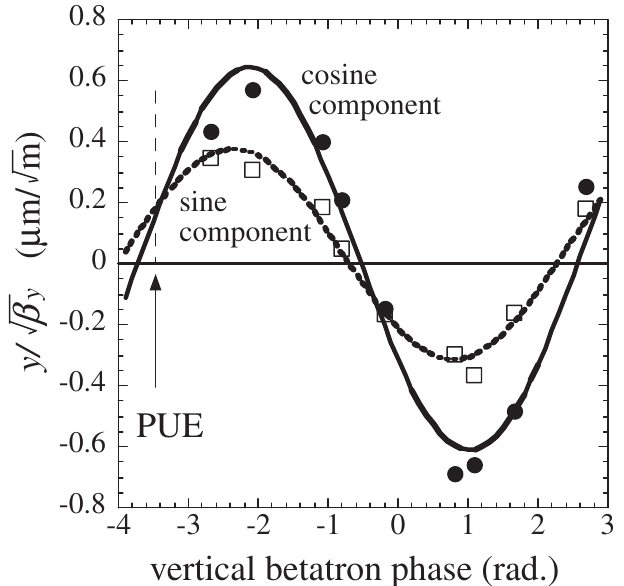
FIG. 6. The cosine and sine components of the vertical oscil- lation amplitude at 60 Hz, measured in the eastern arc. The PUE is located between the two arcs, where the arrow indicates. The sinusoidal lines are the best-fit functions for betatron motion, assuming that there are no vertical dipole errors in this